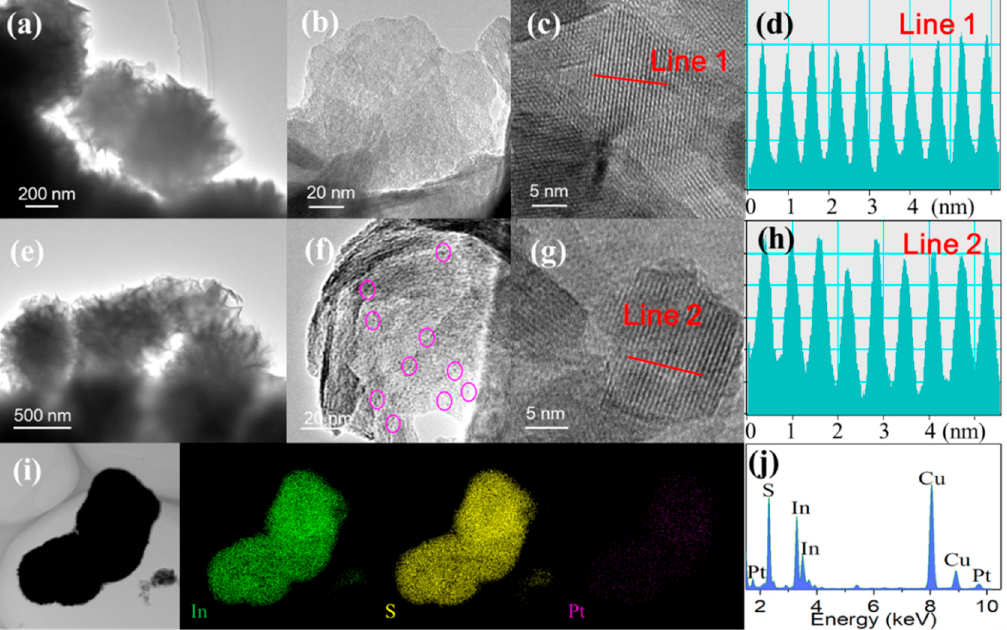
Figure 2. ( a , b ) TEM, ( c ) HRTEM and ( d ) corresponding FFT images of In 2 S 3 . ( e , f ) TEM and ( g ) HRTEM and ( h ) corresponding FFT images of Pt/In 2 S 3 (the Pt clusters are shown in the purple circles). ( i ) EDX-mapping images and ( j ) EDX spectrum of Pt/In 2 S 3 .